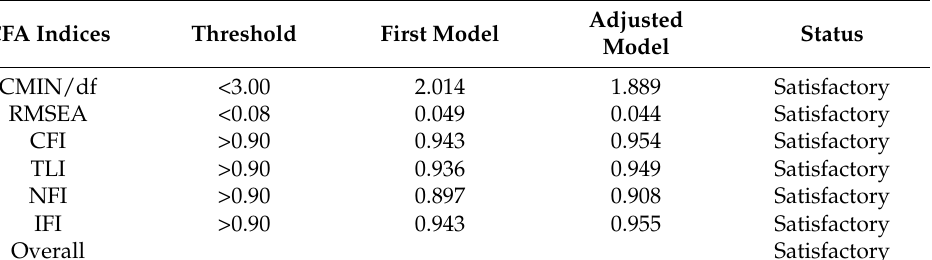
Table 2. CFA Fit Indices.